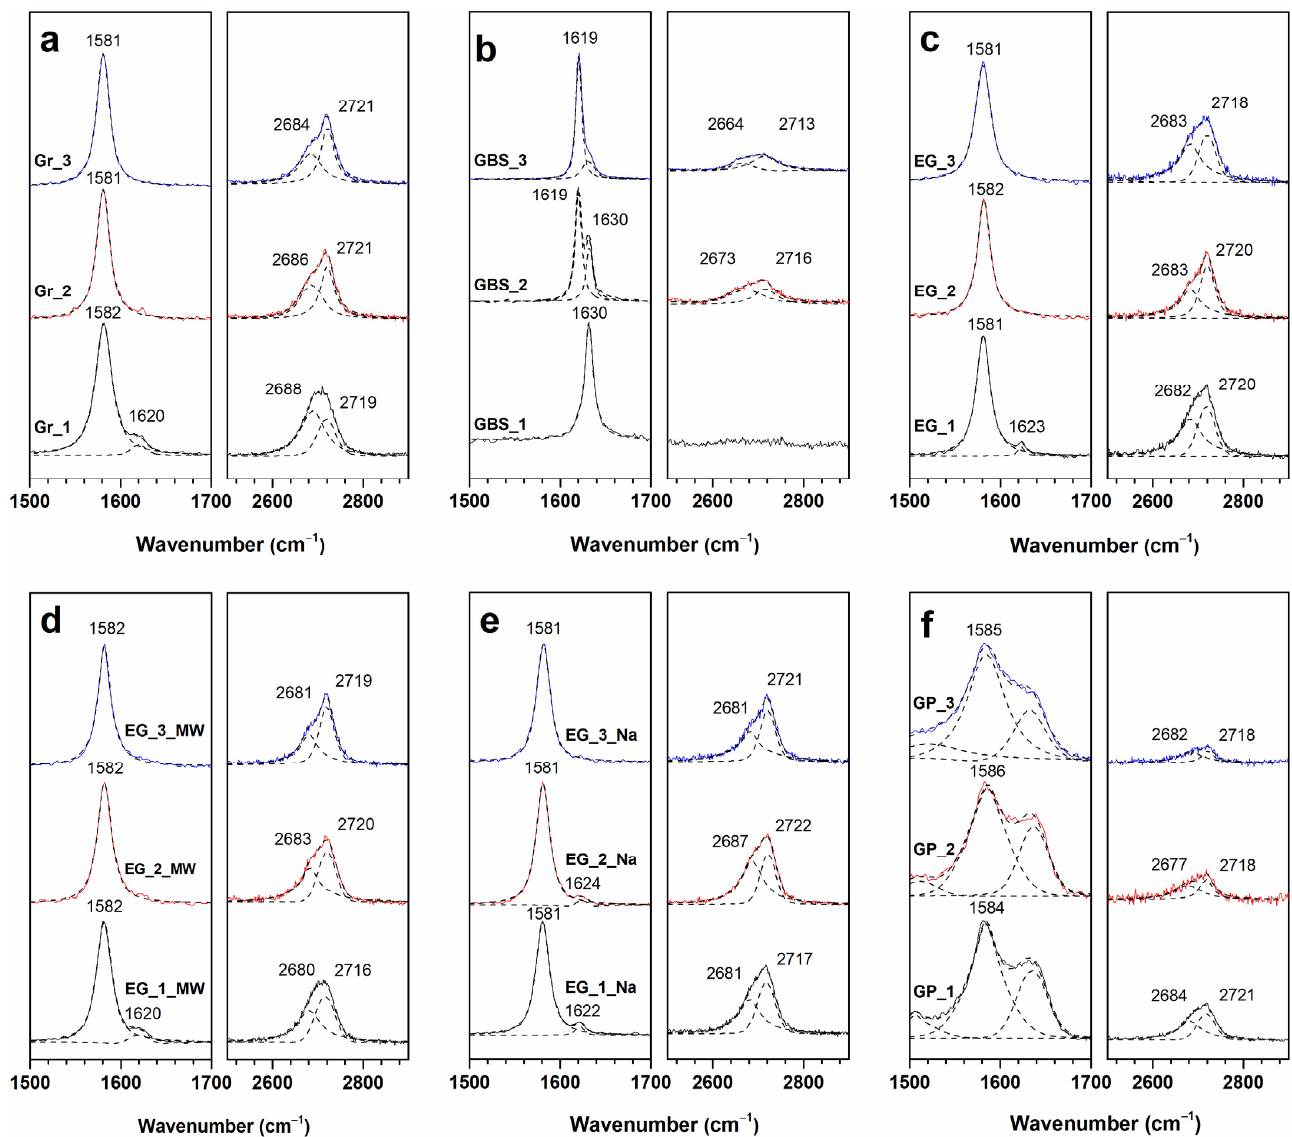
Figure 4. Raman spectra of precursors and GBS products in G (1500–1700 cm − 1 ) and 2D (2500–2900 cm − 1 ) band frequencies: pristine graphite of different grain sizes ( a ), GBS samples ( b ), EG samples ( c ), EG_MW samples ( d ), EG_Na samples ( e ), and EG samples modified with PPy ( f